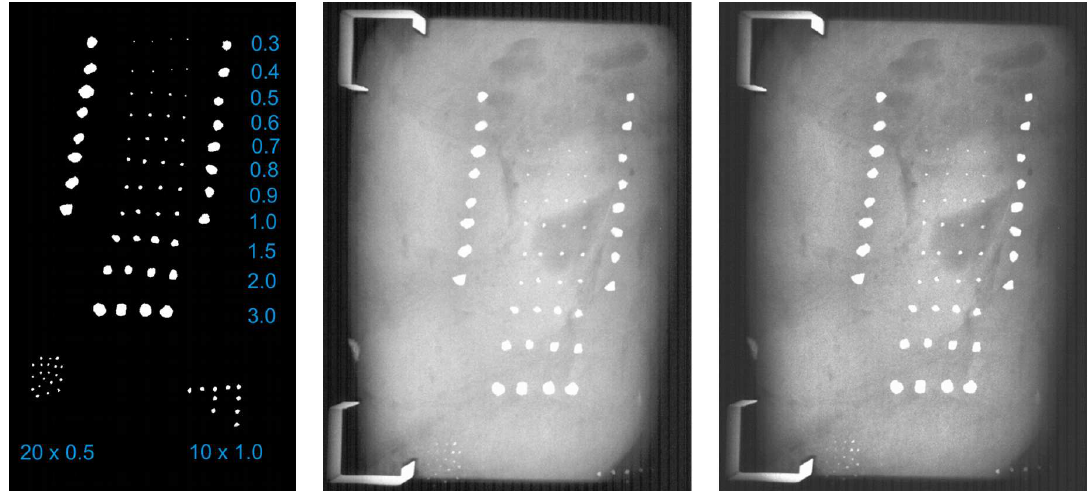
Figure 7. Arrangement of marble grains (left), raw radiography (middle), and processed radiography by the entropic algorithm (right). Average dimension of individual and cluster grains are specified in